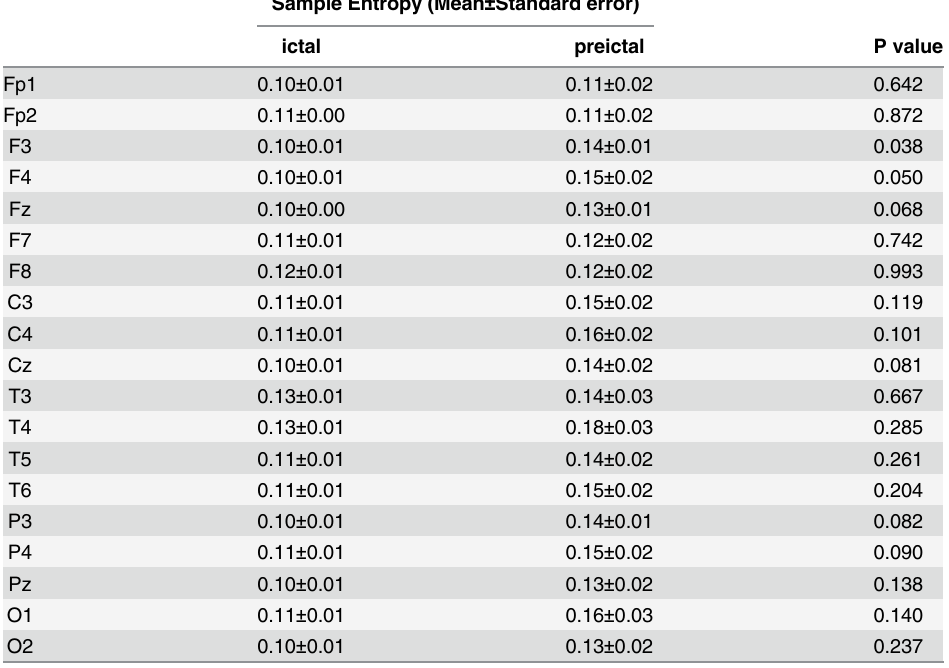
Table 2. Sample entropy in different channels in pre-ictal and ictal states, showing there were no sig- nificant differences in most channels of pre-ictal and ictal state.